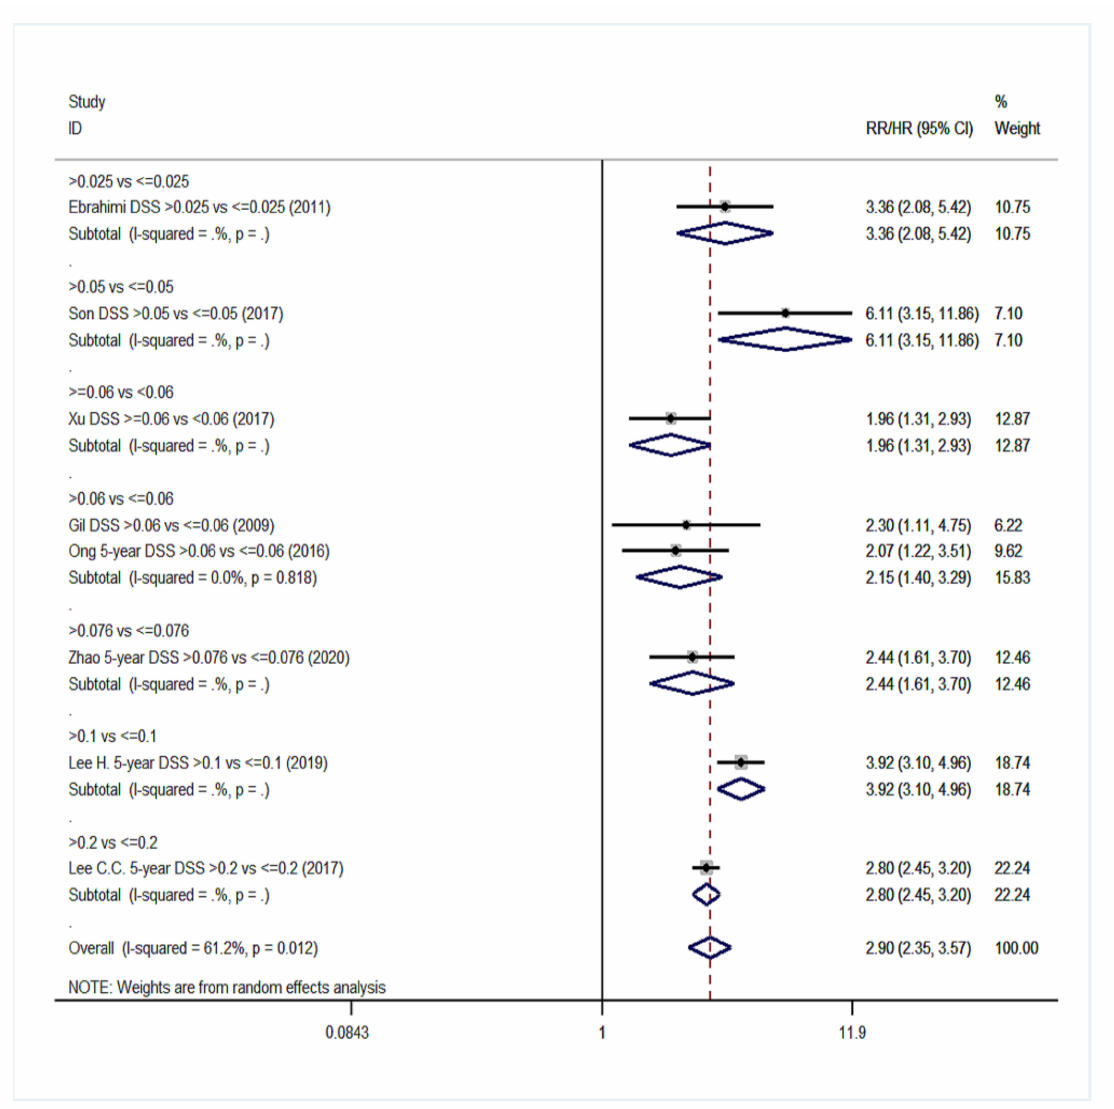
Figure 10. Forest plot demonstrating associations between lymph node ratio (LNR) and disease- specific survival (DSS) in group NO. Apart from the overall analysis, the subanalyses by LNR cut-off values are